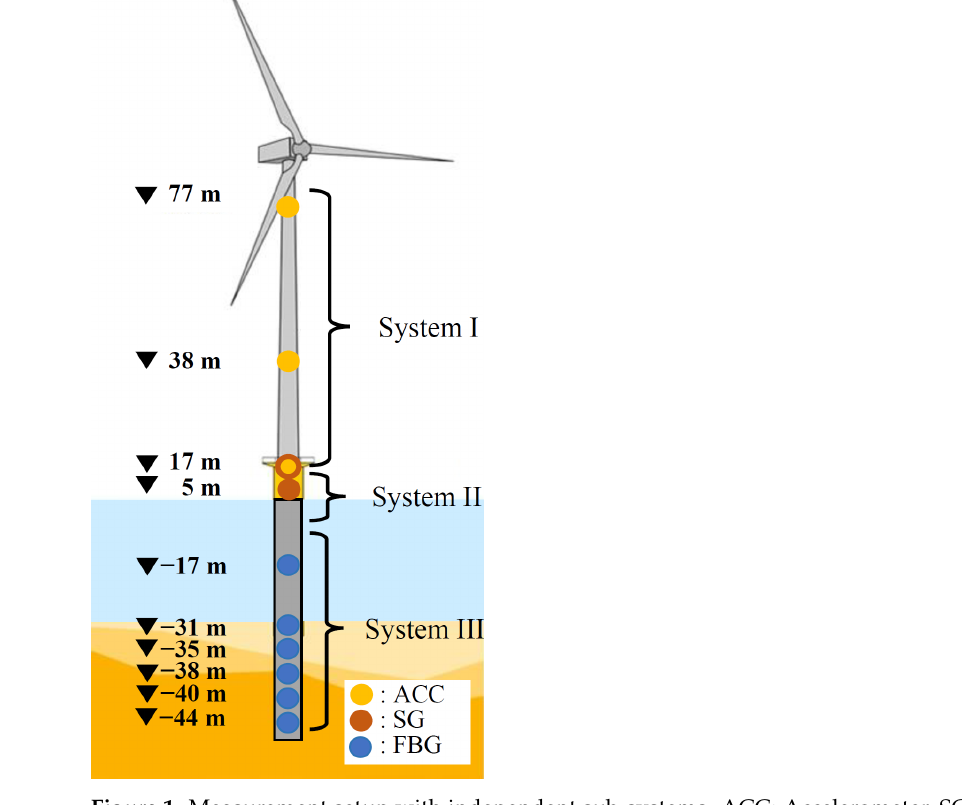
Figure 1. Measurement setup with independent sub-systems. ACC: Accelerometer, SG: Resistive strain gauge, FBG: Optical strain